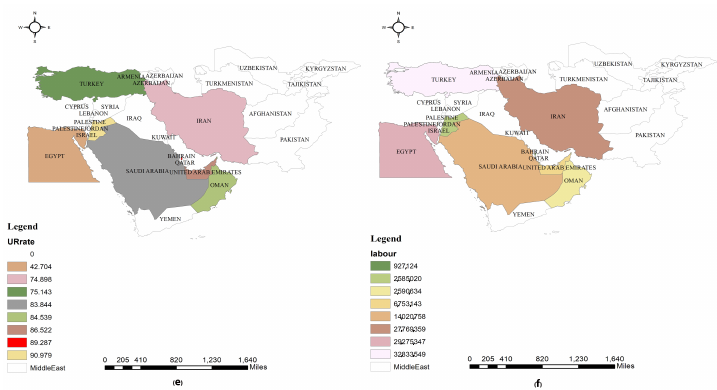
Figure 5. The share of distribution ( a ) “GDP constant on 2010 US, ( b ) Population growth, ( c ) FDI inflow based on US, ( d ) CO 2 diffusion by Kt, ( e ) urbanization rate, and ( f ) labor force growth rate in the selected study areas from 2000 to 2018 (Analysis by: ArcGIS).